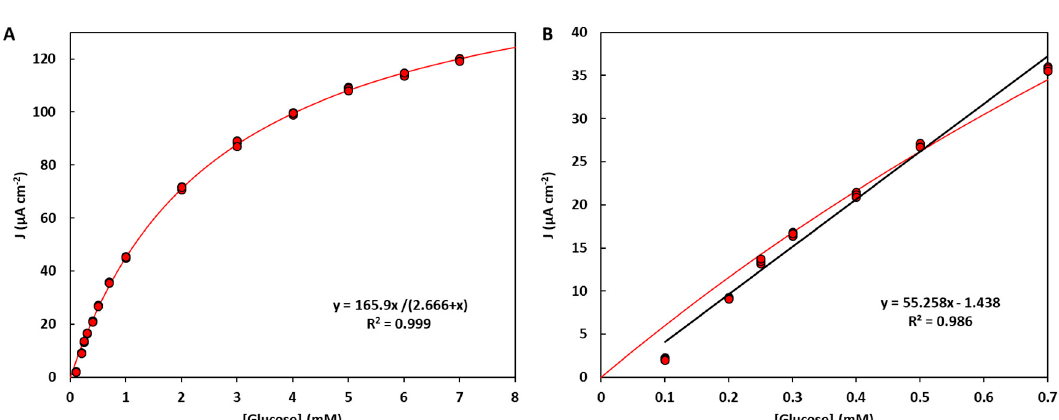
Figure 6. Calibration curve for the self-powered detection of glucose ( n = 3) in a membrane-less cell configuration, using the optimized electrodes and a 10 k Ω resistor setting. The calibration curve can be well described using a Michaelis– Menten law and used across a broad glucose concentration range ( A ), with parameters J max = (165.9 ± 1.6) µ A cm − 2 , K m = (2.67 ± 0.06) mM. A conventional linear calibration can also be used for selected ranges, such as the low concentrations shown in panel ( B ).